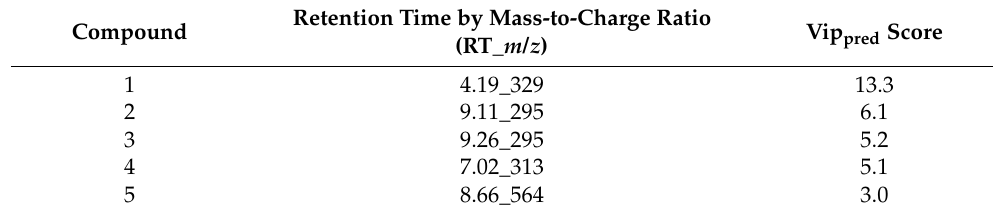
Table 1. OPLS model VIP predictive compounds of whole wheat bread disliking. Compound